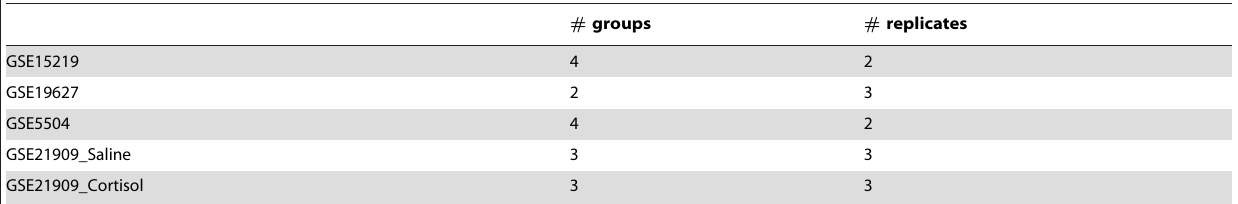
Table 1. GEO sources.